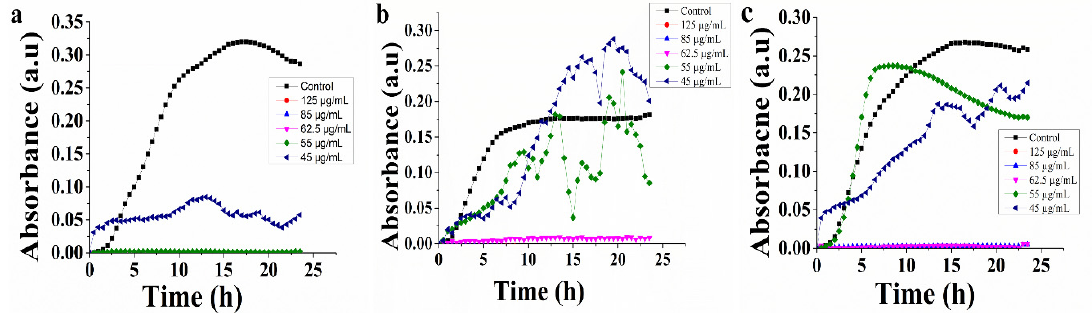
Figure 5. Analysis of growth curve for S. aureus ( a ) , VRSA ( b ), and MRSA ( c ) treated with TGQD. Data represent the mean ± SD, n = 5. VRSA = vancomycin resistant S. aureus . Table 1. Determining the Minimum Inhibitory Concentration (MICs) of TGQD by the broth microdilution method.